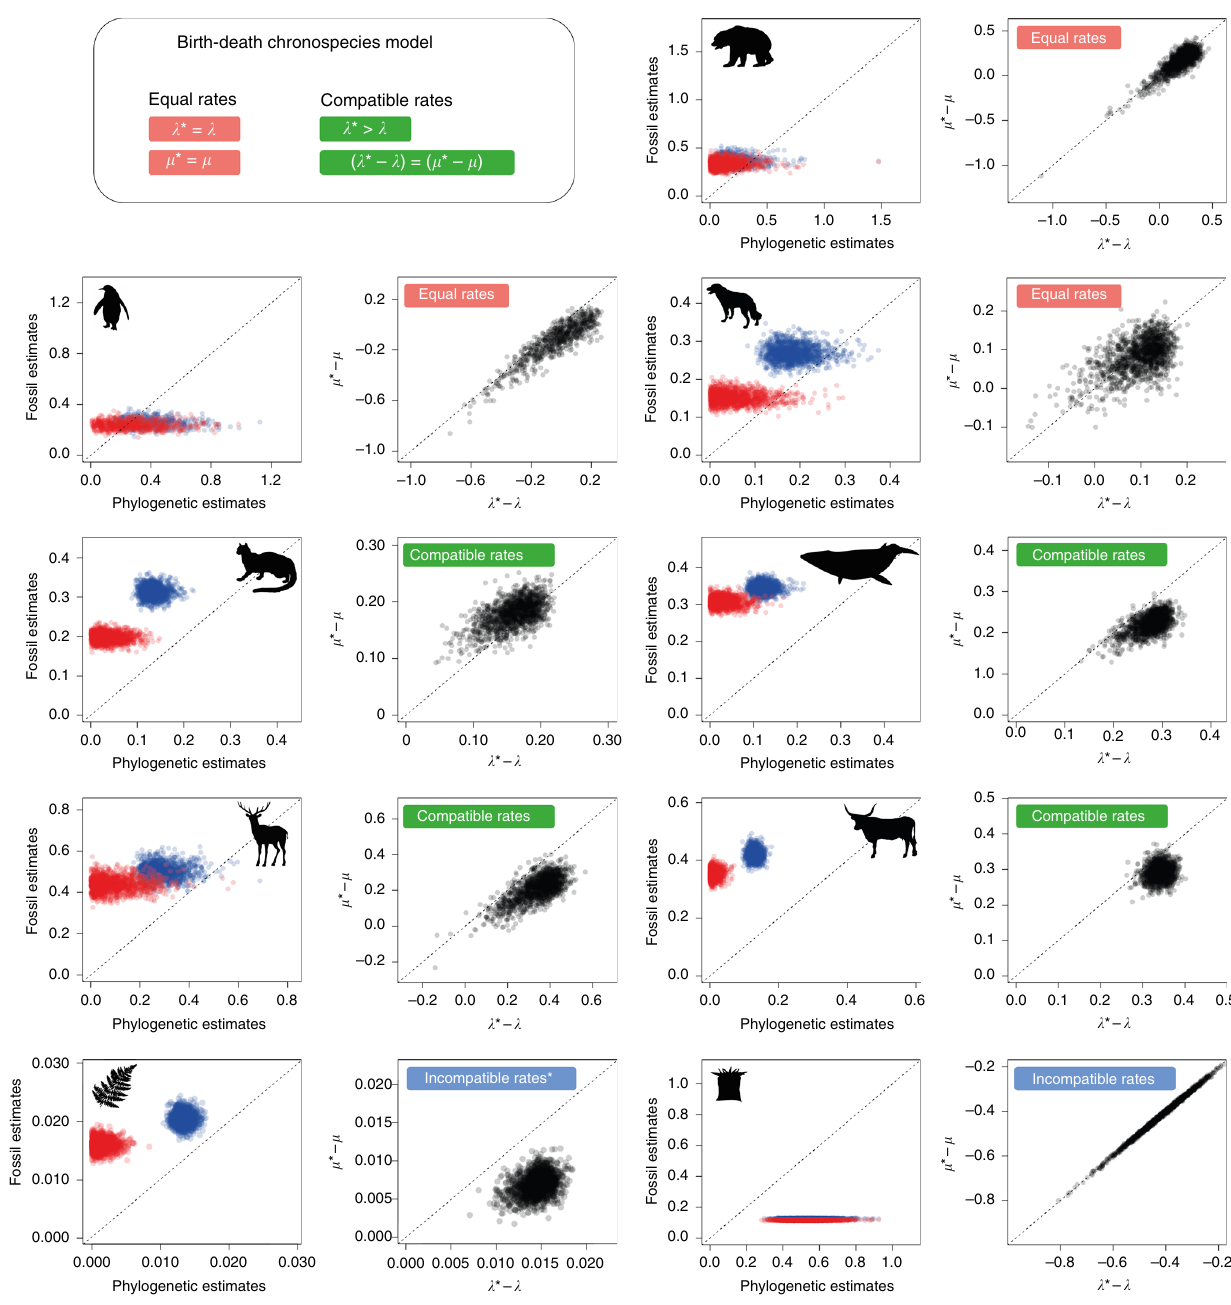
Fig. 3 Results from a Bayesian analysis of fossil and phylogenetic data for nine clades. Posterior samples of speciation rates (in blue) and extinction rates (in red) jointly inferred from the two data types are plotted against one another; posterior samples of the two terms of Eq. (5) are shown in black. The results shown here are based on the assumption of constant rates through time. The clades include (from top to bottom): Ursidae, Sphenisciformes, Canidae, Feliformia, Cetacea, Cervidae, Bovidae, ferns and allies, and Scleractinia (see also Methods; animal silhouettes from www.phylopic.org; fern silhouette from www.publicdomainpictures.net). Although the analyses were run assuming independent rates ( λ , μ , λ *, μ *), their joint posterior samples were used to assess which model (equal rates, compatible rates, or incompatible rates) best fi t the data. The best model, indicated by the labels in the plots, is based on whether the posterior samples conform to the properties of the models (summarised in the top left panel) using a 99% threshold for signi fi cance. Consistent results were also obtained in a maximum likelihood framework (Table 1). The equal rates model is supported in three data sets, i.e. stratigraphic and phylogenetic rates are not signi fi cantly different. Stratigraphic and phylogenetic speciation and extinction rates are signi fi cantly different in four data sets, but compatible with the expectations of the BDC model. Finally, origination and extinction rates are signi fi cantly different in two data sets and the discrepancy cannot be explained by different speciation modes. However, the fern data set (bottom left) supported a BDC model after accounting for rate variation through time (Fig.